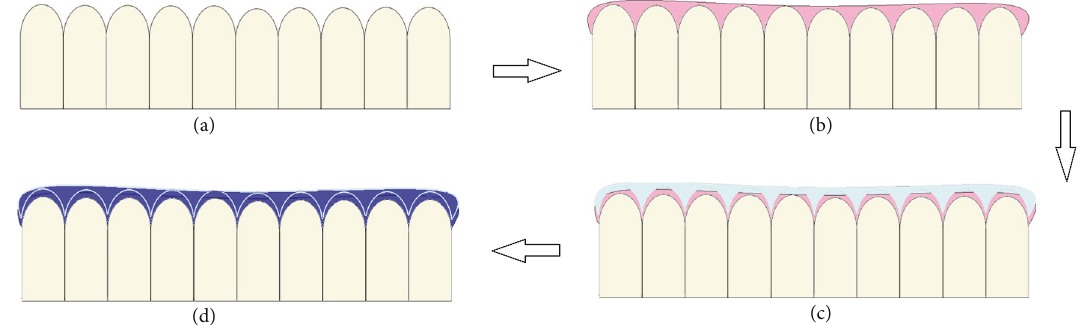
Figure 2: The process of in situ interfacial polymerization [11, 14]: (a) creation of a support layer by phase inversion; (b) distribution of diamine aqueous solution on the membrane surface; (c) distribution and mixing of polyacyl chloride dissolved in an organic solvent on the membrane surface; (d) polymerization reaction, formation of the polyamide skin